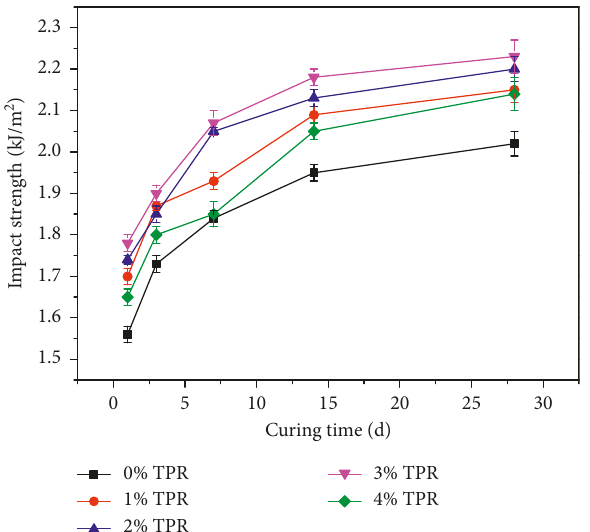
Figure 10: Impact strength of cement stone with different TPR contents for different curing times.